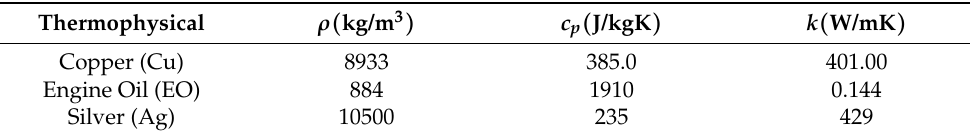
Table 2. Material specifications at 20 ◦ C